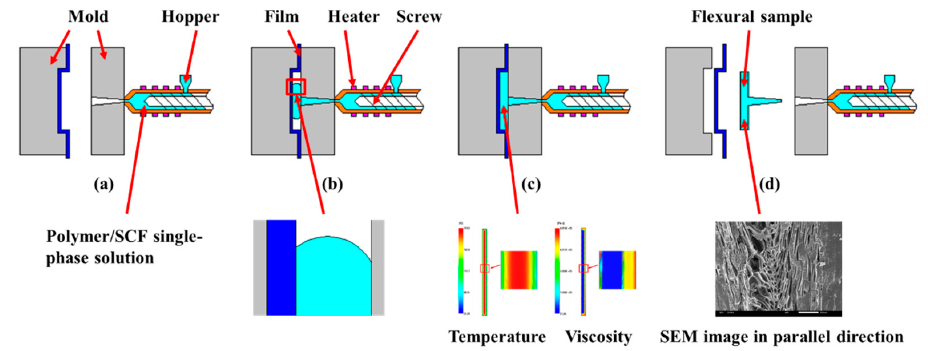
Figure 1. Schematic diagram of the IMD/MIM: ( a ) pasting film before injection; ( b ) injecting polymer/SCF single-phase solution; ( c ) cooling molding; ( d ) ejecting flexural sample.